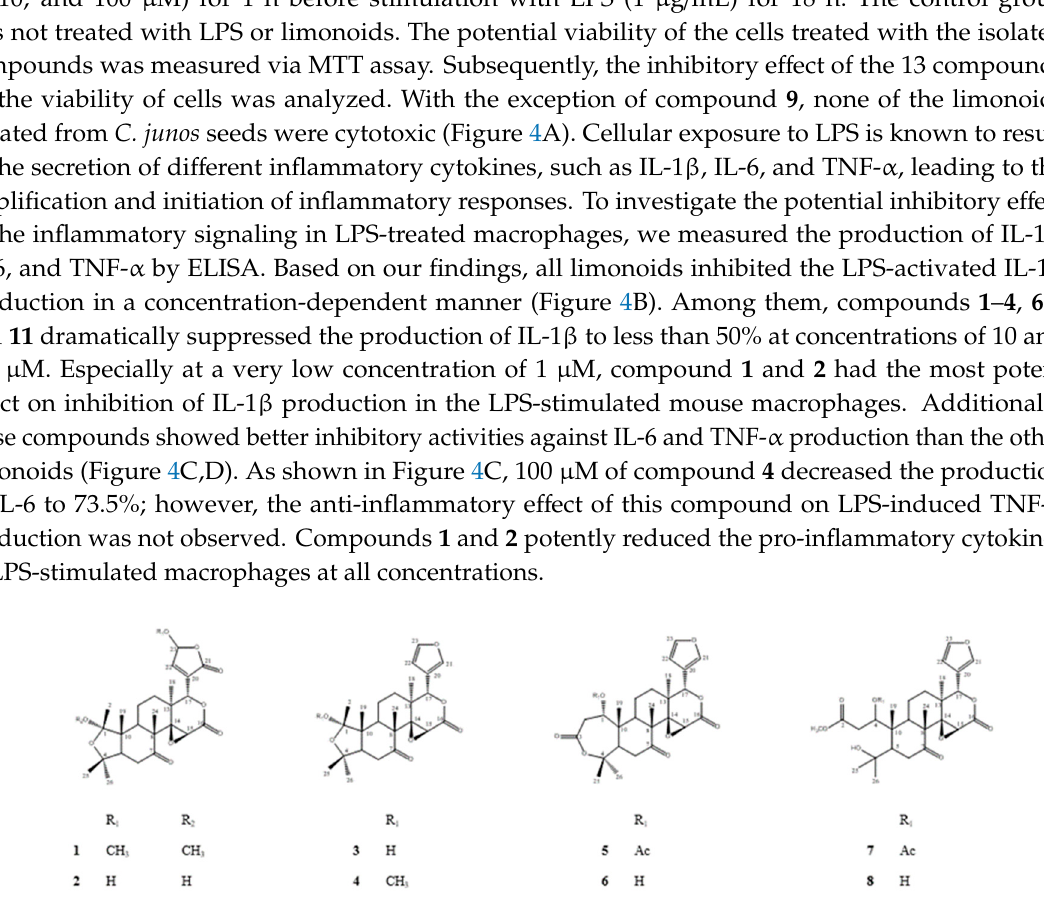
Figure 2. Key 2D NMR correlations for compound 1 .